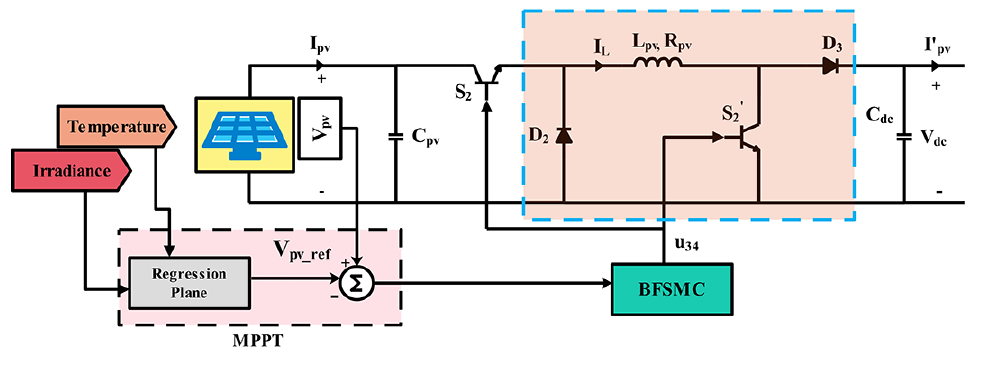
Figure 3. PV energy system